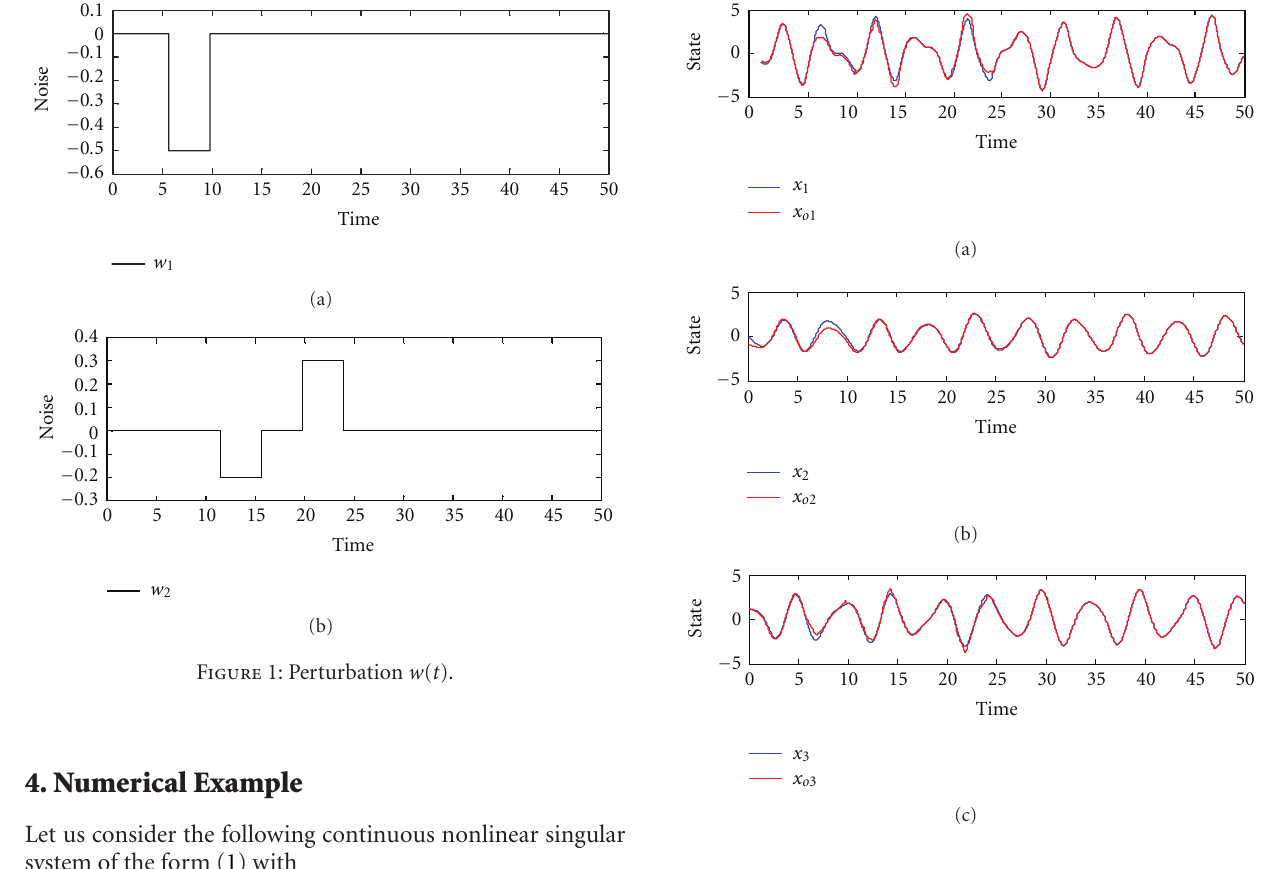
Figure 2: x i (blue) and (cid:7) x i